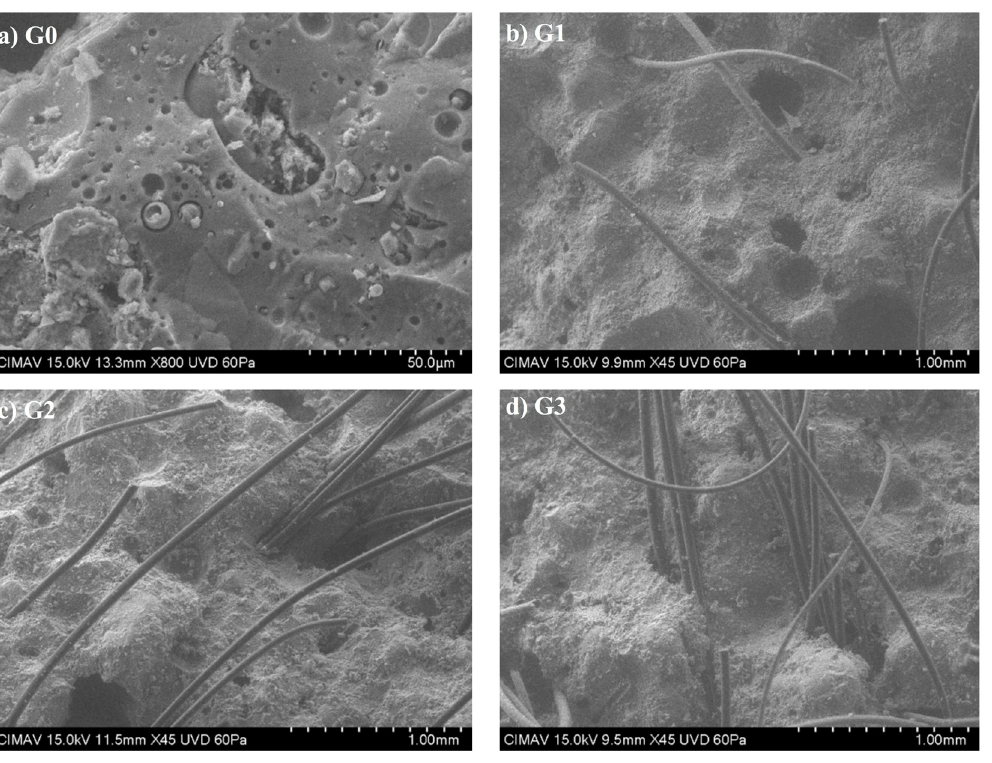
Figure 7. SEM micrographs of the geopolymer composites: ( a ) 0% PPF, ( b ) 0.5% PPF, ( c ) 1% PPF and ( d ) 1.5% PPF.